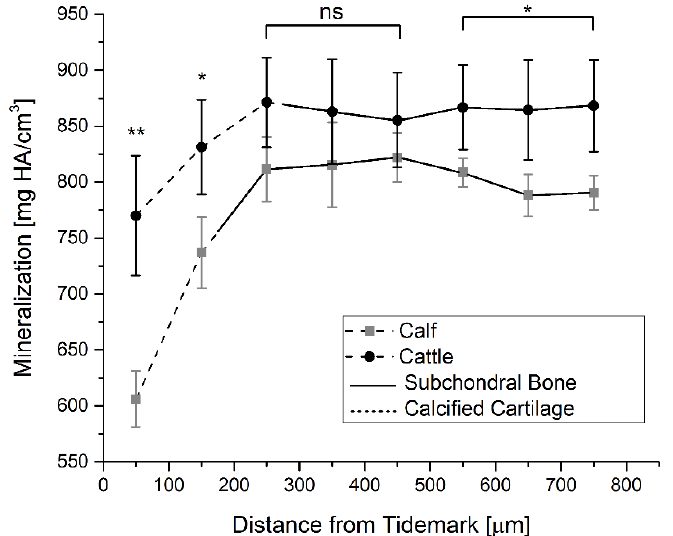
Figure 3. Age/depth-related mineralization of the subchondral bone. Compared to calves, cattle showed higher mineralization values at all distances from the tidemark. The differences were significant at initial (50–150 µ m) and far down (550–750 µ m) distances from the tidemark, while in the midsection of the SCZ non-significant differences between the age groups were observed. (** p < 0.01, * p < 0.05) Close to the tidemark, mineralization was significantly lower compared to the region of the SCBP.